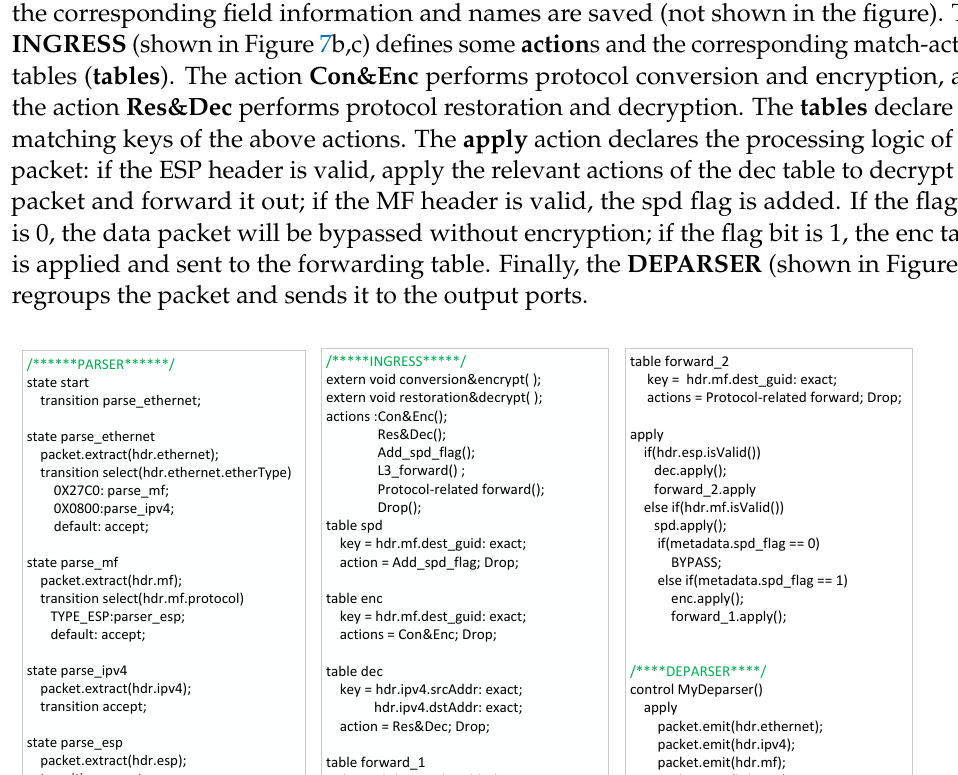
Figure 7. Analysis and processing flow of a MF